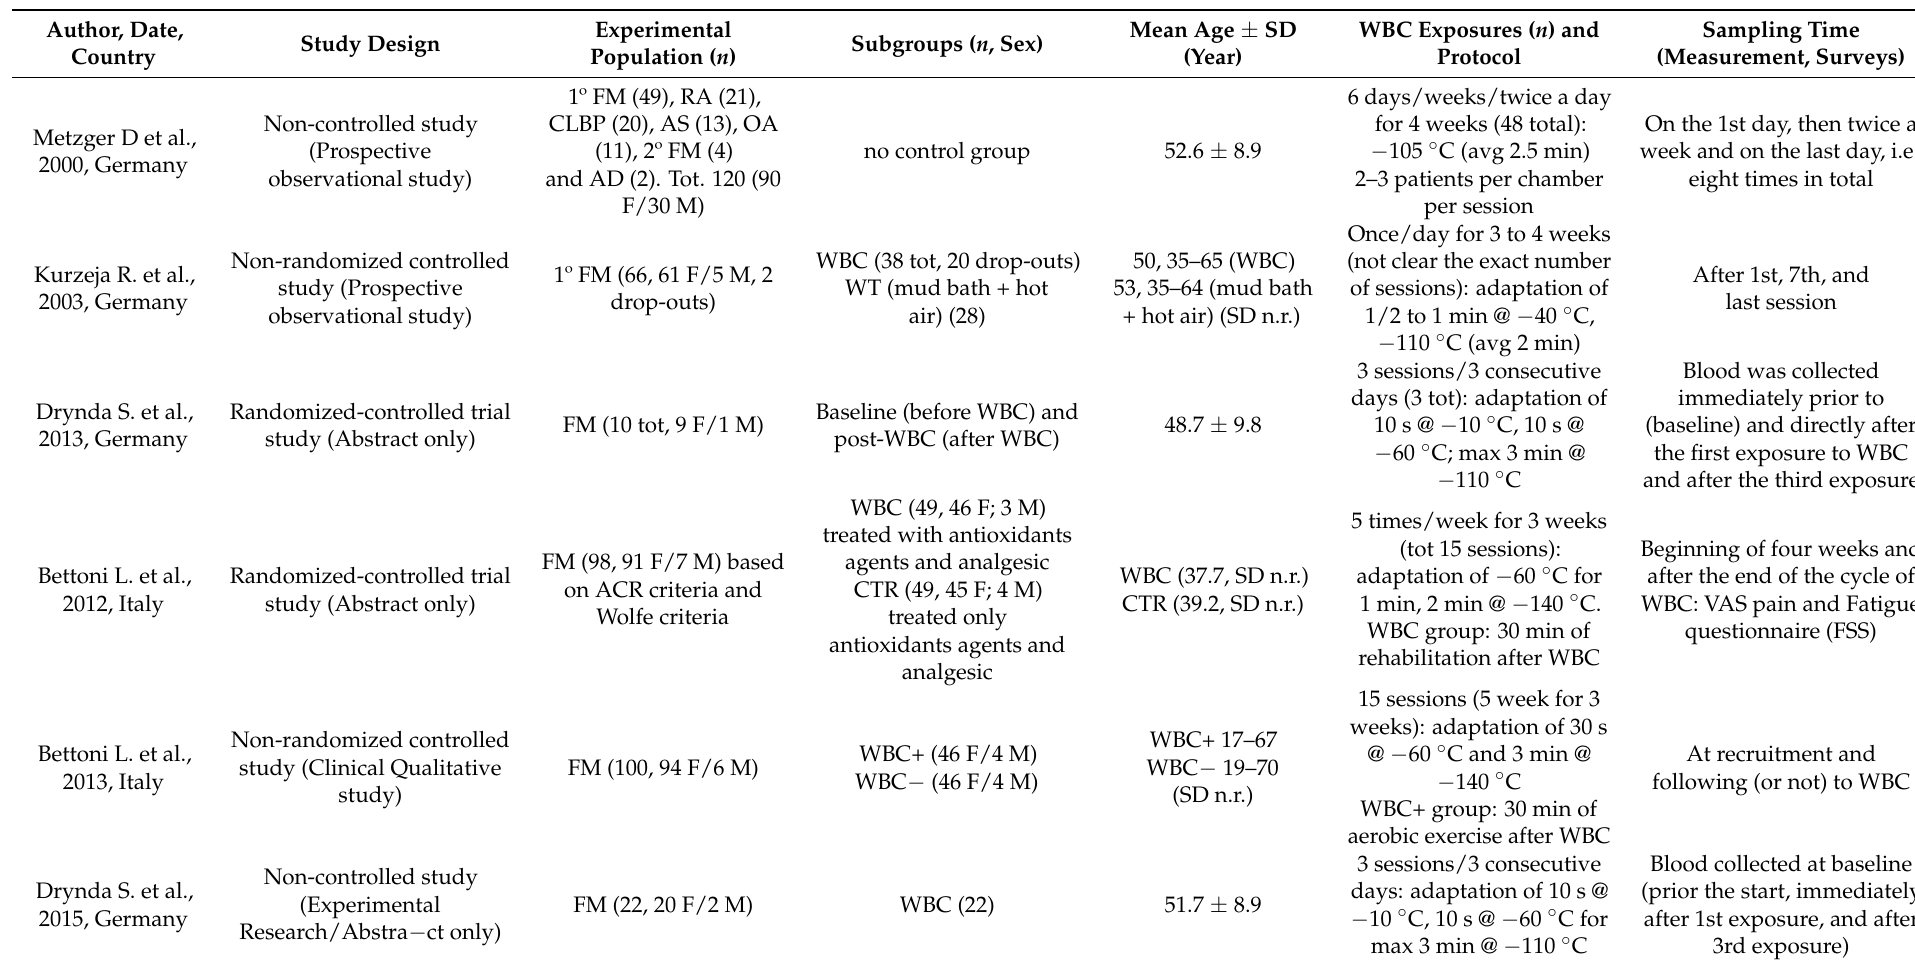
Table 2. Summary of included studies